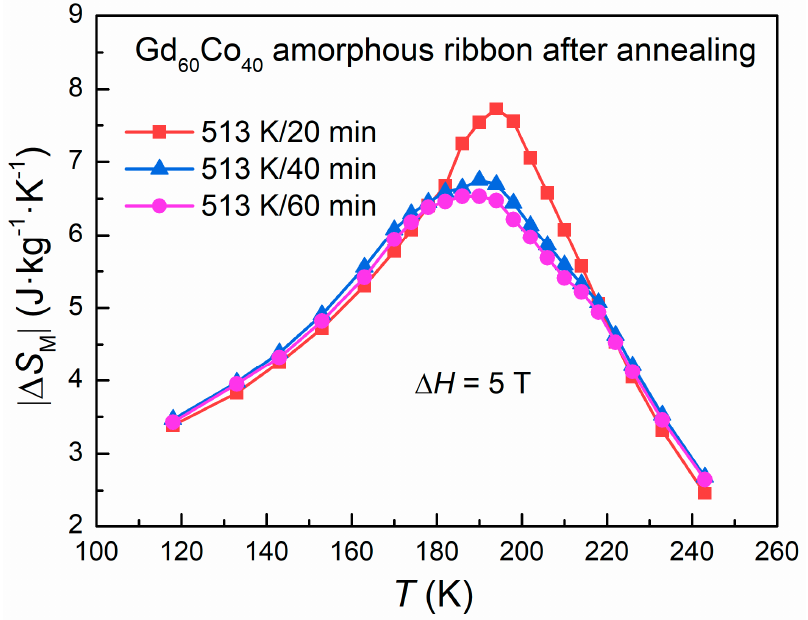
Figure 5. The relation of | Δ S M | to temperature for the different annealed Gd 60 Co 40 alloy